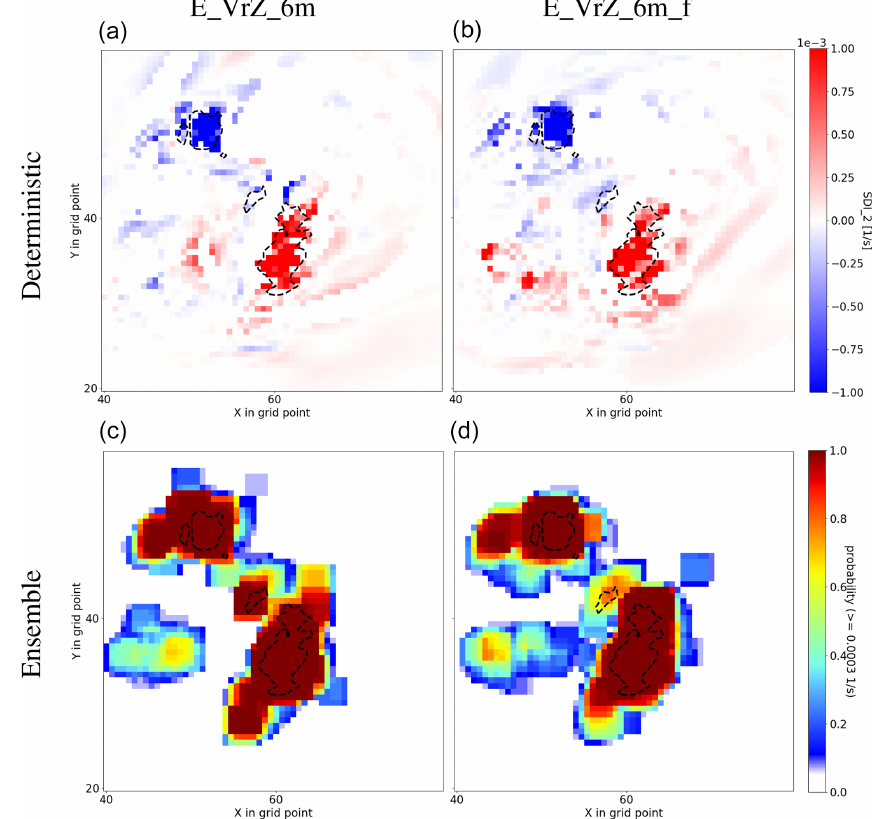
Figure 7. SDI 2 of the analysis of the deterministic run (a, b) and ensemble (c, d) for E_VrZ_6m (left) and E_VrZ_6m_f (right) at 15:00UTC. SDI 2 ≥ 0 . 0003s − 1 in the nature run is denoted with dashed contour lines. For the ensemble, probabilities exceeding the threshold value of 0.0003s − 1 are calculated using a neighborhood of box length 8km.